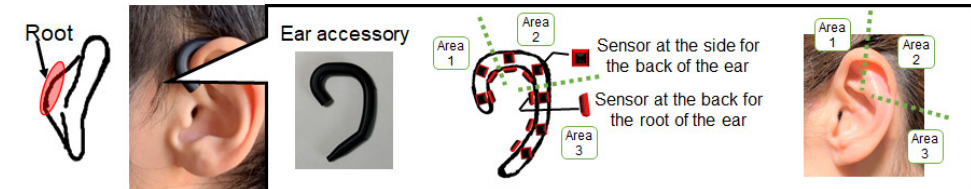
Figure 2. Ear-root-mounted device. Reprinted/adapted with permission from Ref. [11] 2021,